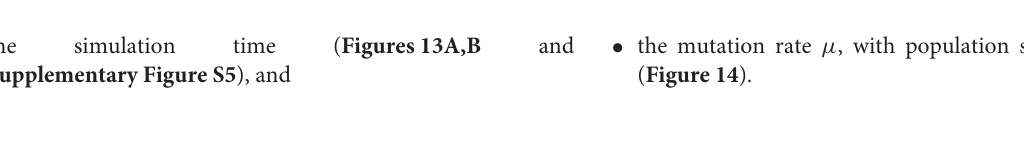
• the simulation time ( Figures 13A,B and Supplementary Figure S5 ), and